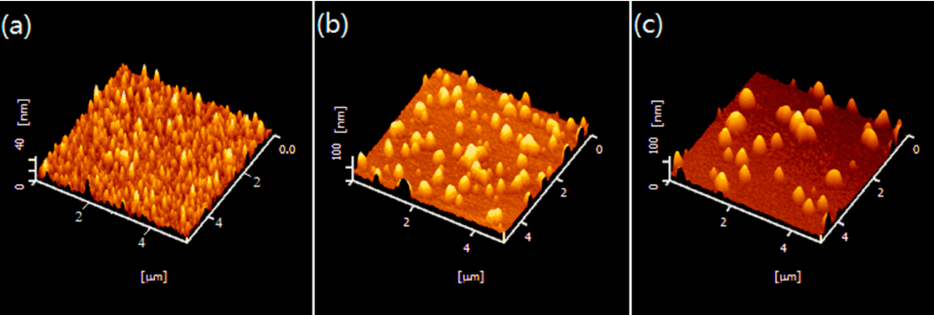
Figure 2. The 3D AFM images (5 µ m × 5 µ m) for GaN NL after annealing ( a – c ) with 0, 2 and 4-min annealing